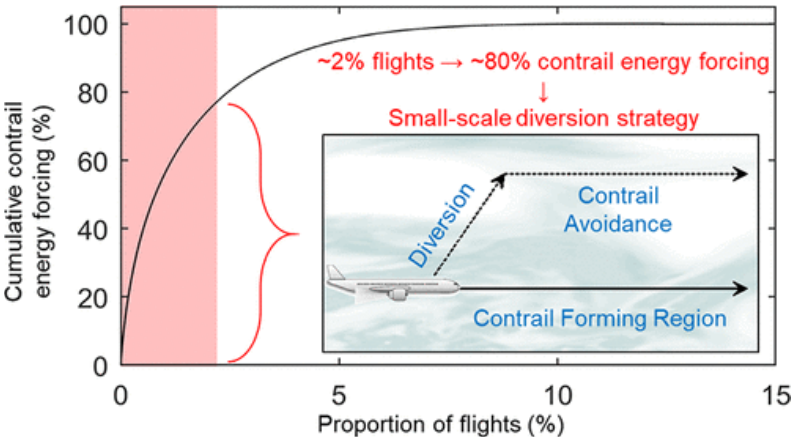
Figure 19. Schematic representation of contrail avoidance strategy. Plot of cumulative contrail energy forcing against proportion of flights. Reprinted with permission from [181]. Copyright 2022, American Chemical